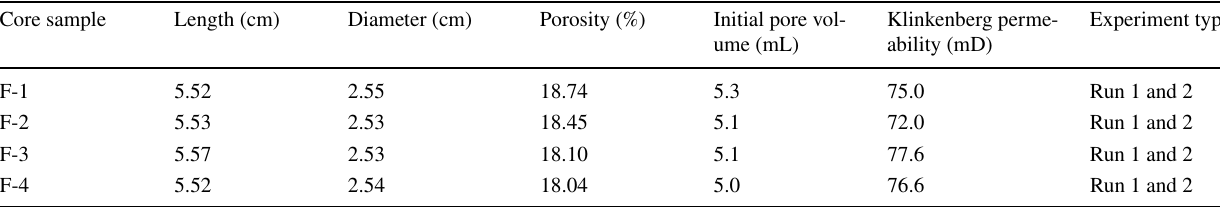
Table 1 Core sample properties and type of experiment Core